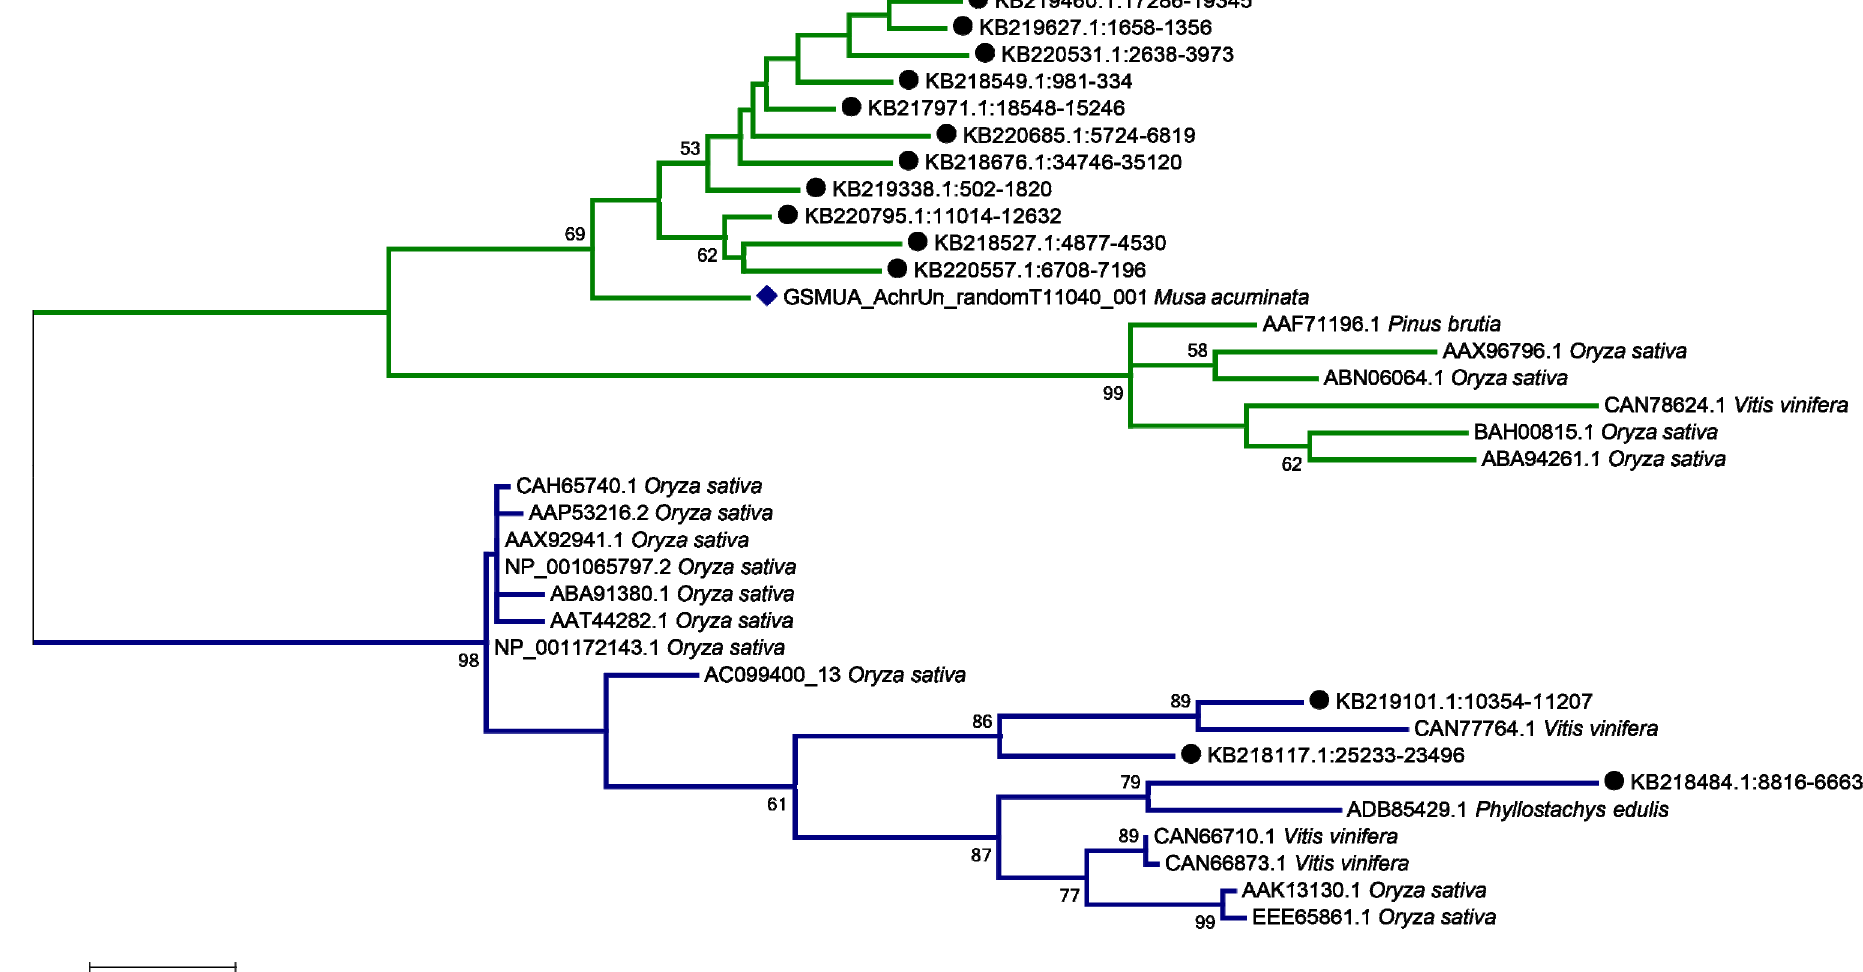
Figure 6. Maximum-Likelihood phylogenetic tree for enset integrase core-domain proteins. Protein sequences from E. ventricosum are indicated by circles. Bootstrap values of greater than 50% are indicated as numbers on the